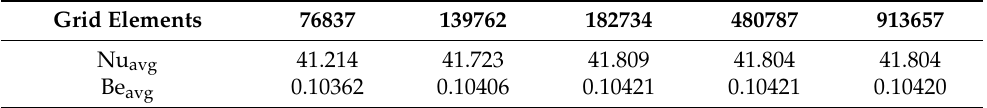
Table 3. Different mesh sizes for Ha = 0, Ω = 0, and ϕ = 0.02. Grid